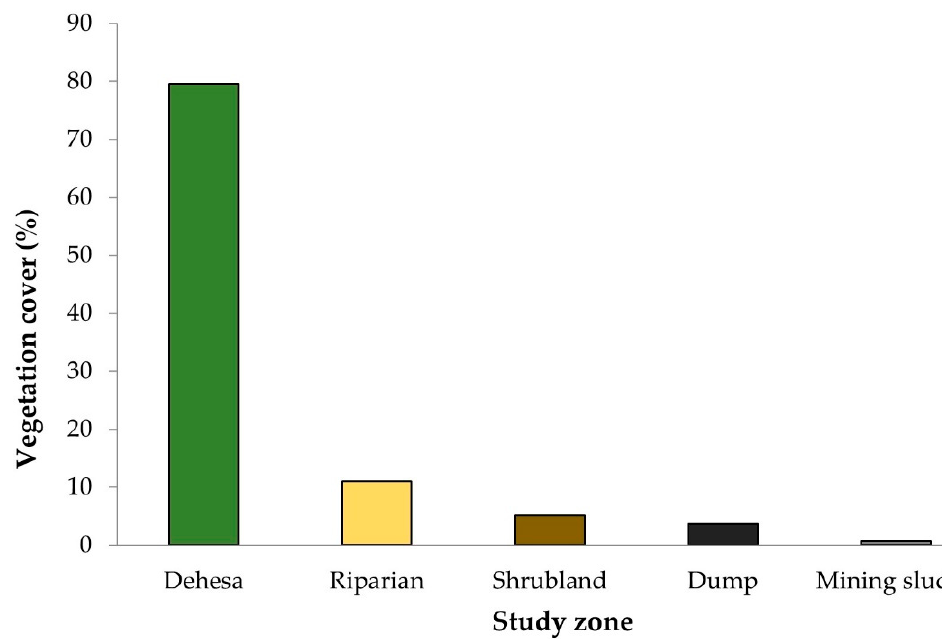
Figure 5. Vegetation cover.